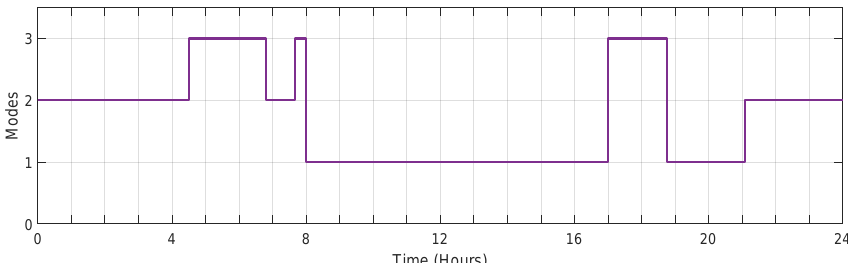
Figure 7. Different operation modes achieved by the proposed strategy when used to manage the energy in a smart home equipped with EV without